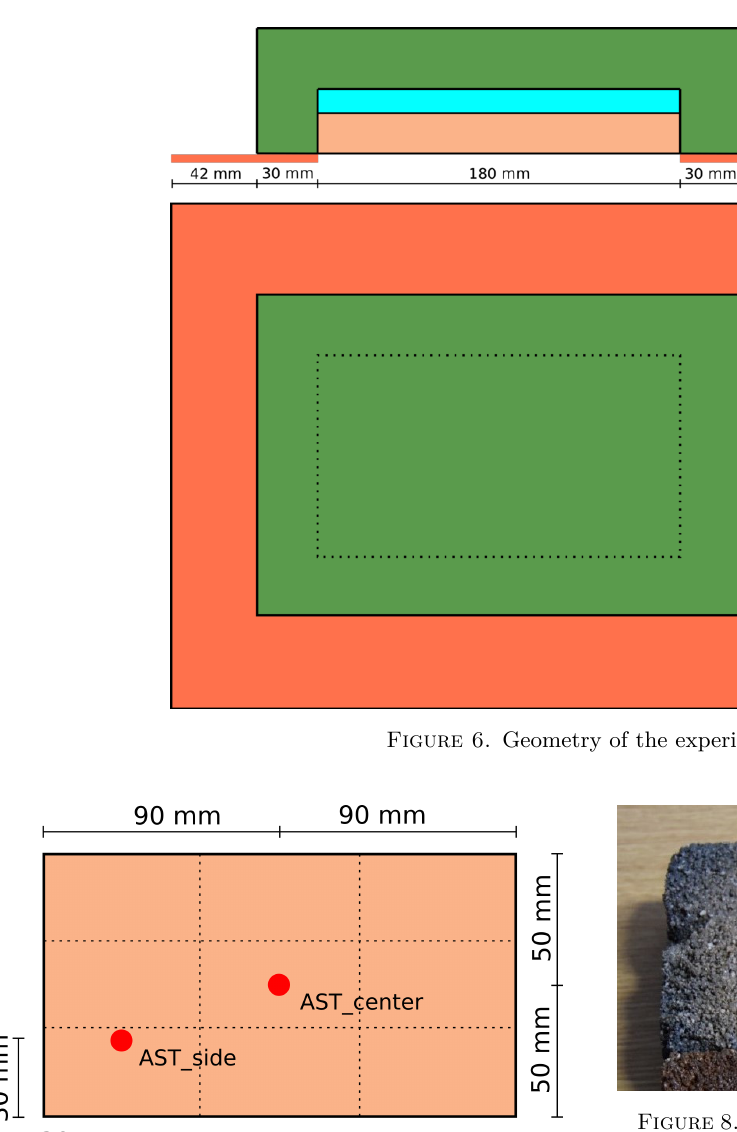
Figure 8. H-cement mortar after the experiment and after fast cooling in